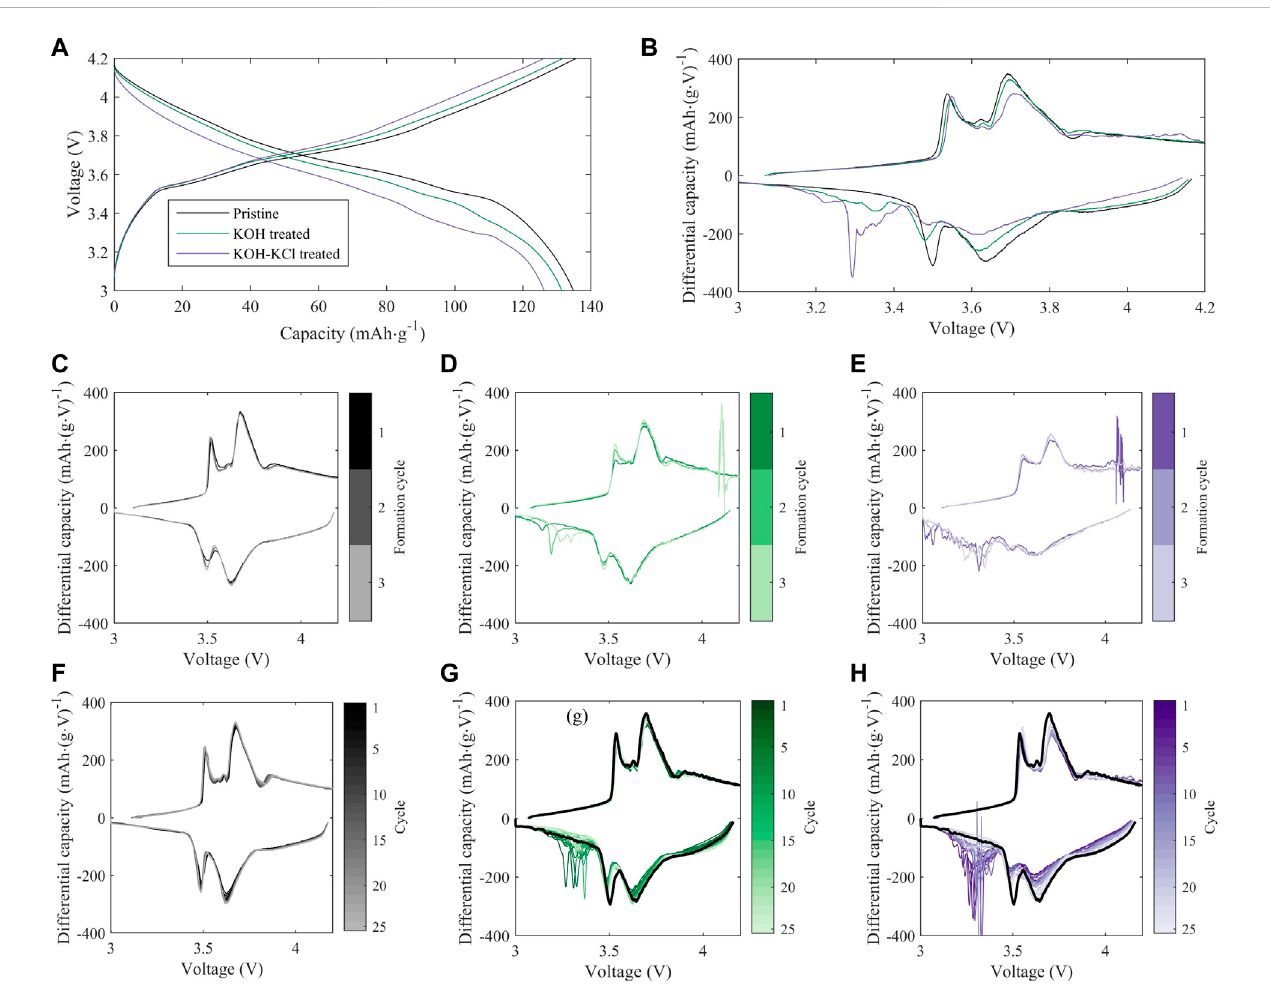
FIGURE 7 Evolution of full-cell electrochemistry with cycling for treated vs. pristine NMC-111: (A) Full-cell voltage pro fi les at the 10th C/10 cycle following formation; (B) Differential capacity (dQ/dV) pro fi les for the cells and cycle in (A) ; (C – E) : Evolution of differential capacity during formation cycling for (C) pristine, (D) KOH-treated,and (E) KOH + KCl-treated cells; (F – H) Evolution ofdifferential capacity during 25subsequent C/10cyclesfor (F) pristine, (G) KOH- treated, and (H) KOH + KCl-treated cells. For (C – H) , line colors indicate the cycle number, increasing from dark to light tones. In (G,H) , black overlay indicates the fi rst post-formation cycle of the pristine cell in (F) . In all sub-plots, data from a single representative cell replicate is